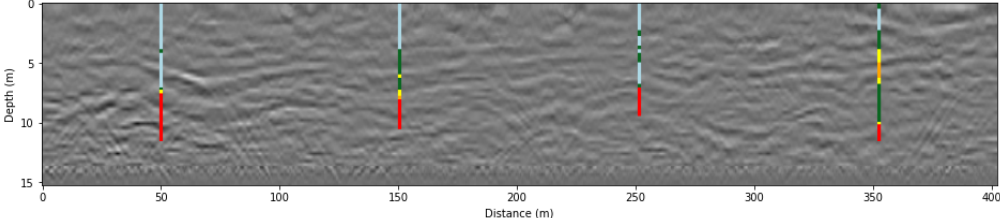
Figure 5. Example of a GPR track augmented with exploration hole data. The exploration holes are coloured by relative SiO 2 values. From low to high percentages, SiO 2 is coloured as: light blue, green, yellow, orange, and red.